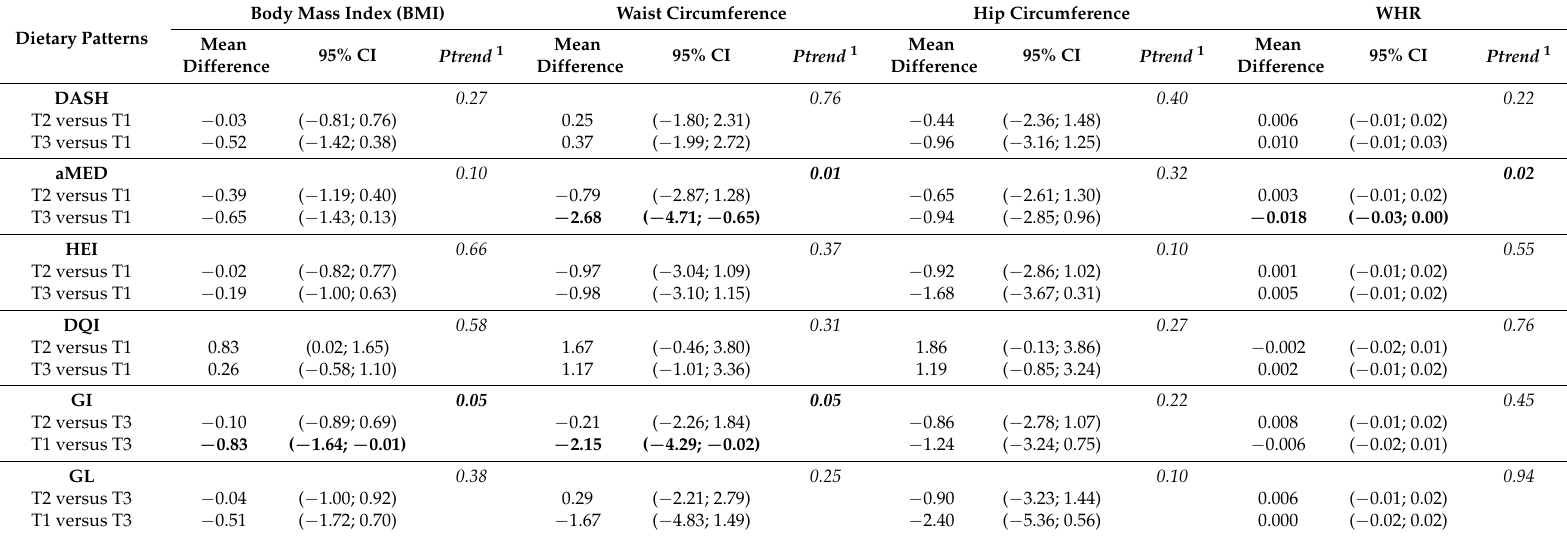
Table 3. Associations between a priori diet scores and anthropometric measurements, adjusted for age, education, center, energy intake, and physical activity. Dietary